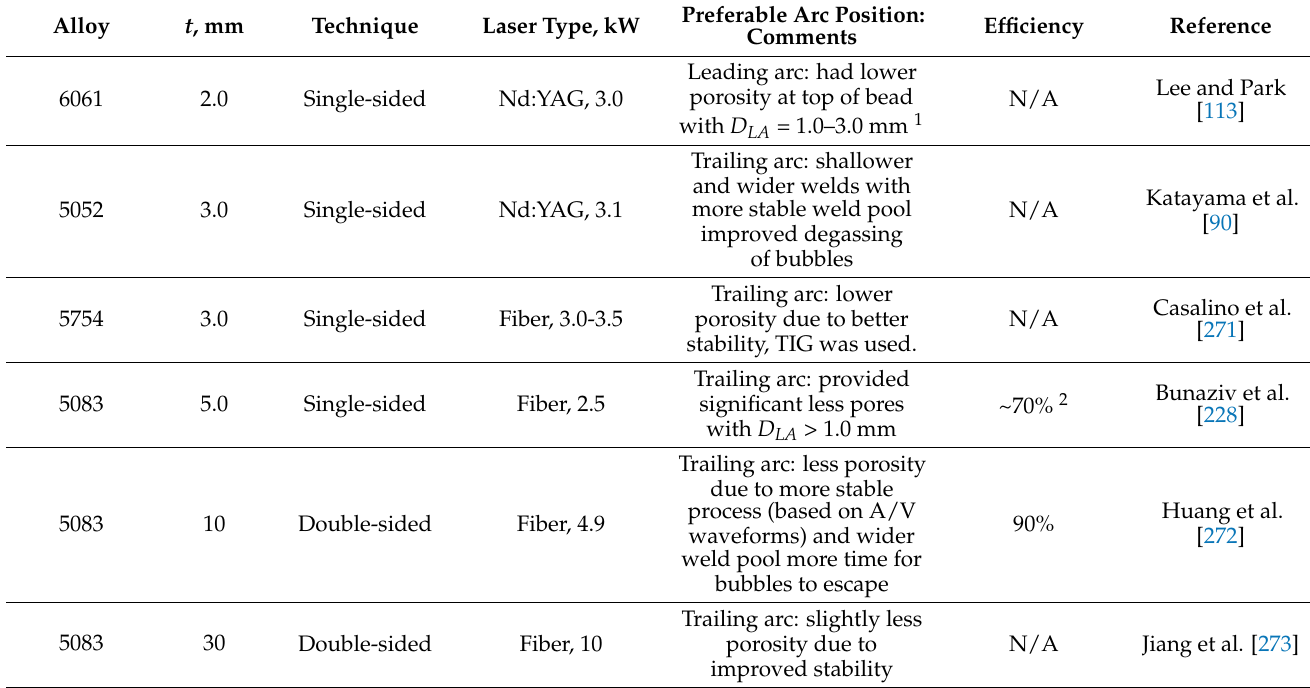
Table 4. Result of laser-arc hybrid welding on porosity formation and resulting strength. MIG source was used. References compiled in chronological